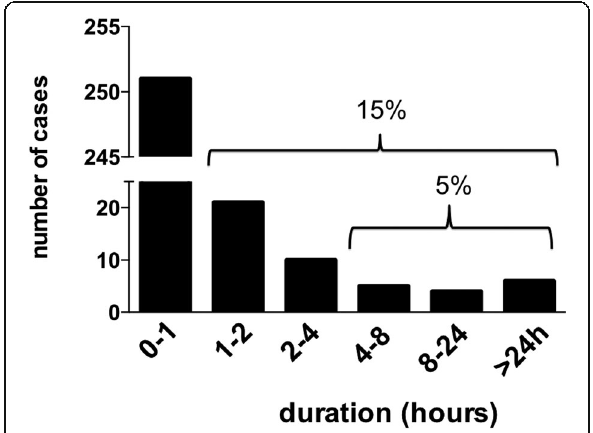
Fig. 1 Distribution of duration of all aura symptoms ( n =297).